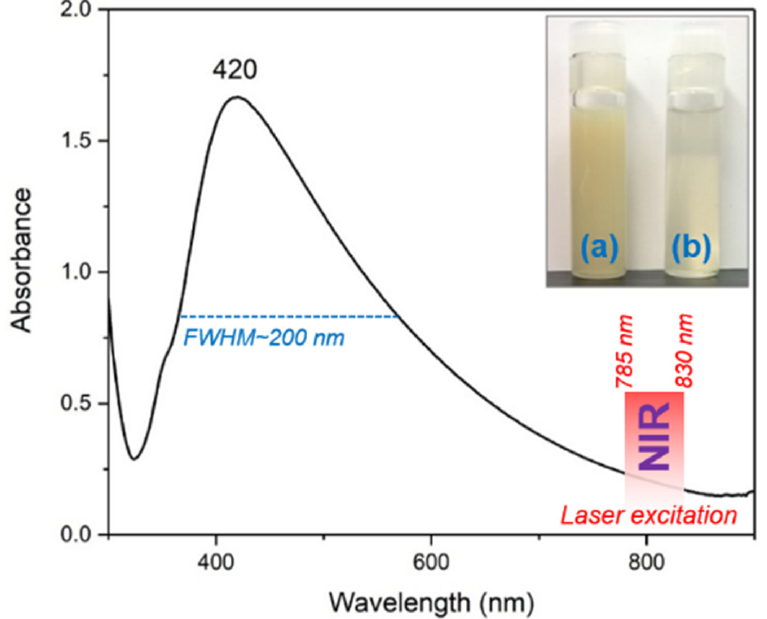
Figure 1. UV-Vis absorption spectra of the colloidal solution containing AgNS. The inset shows an optical image of the colloidal solutions before ( a ) and after purification through centrifugation ( b ) respectively.